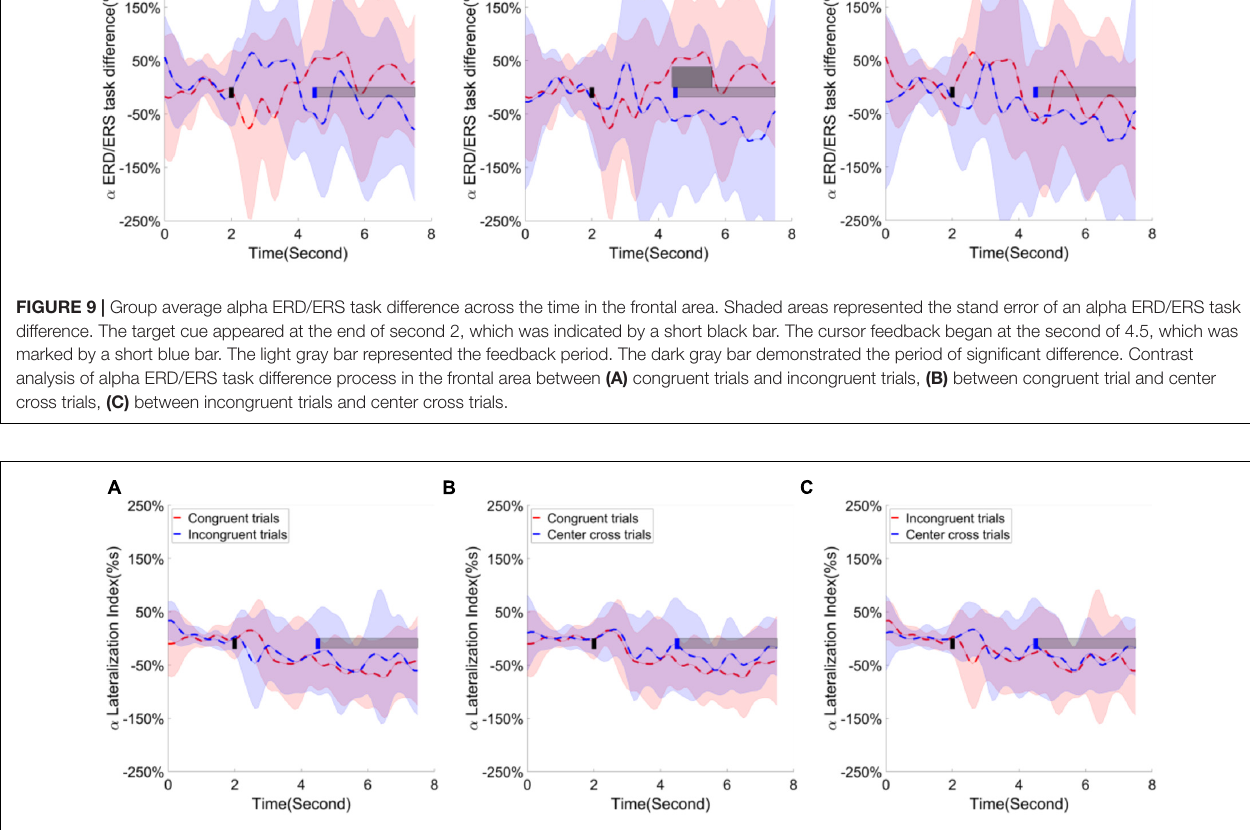
FIGURE 10 | Group average alpha lateralization index across the time in the sensorimotor area. Shaded areas represented the stand error of a lateralization index. The target cue appeared at the end of second 2, which was indicated by a short black bar. The cursor feedback began at the second of 4.5, which was marked by a short blue bar. The light gray bar represented the feedback period. Contrast analysis of lateralization process in the sensorimotor area (A) between congruent trials and incongruent trials, (B) between congruent trial and center cross trials, (C) between incongruent trials and center cross trials.